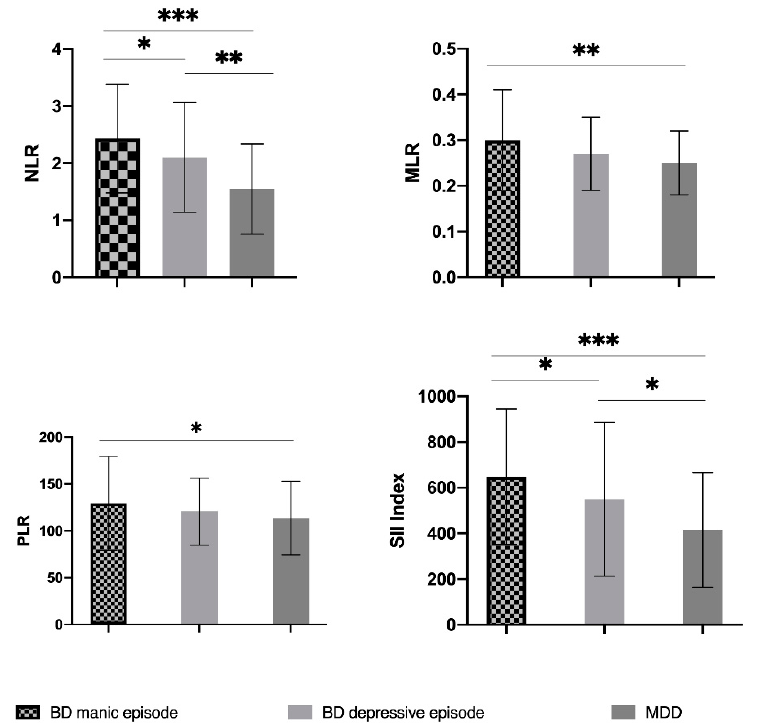
Figure 1. Neutrophil-to-lymphocyte ratio, platelet-to-lymphocyte ratio, monocyte-to-lymphocyte ratio, and systemic immune-inflammatory index levels in bipolar disorder patients with manic episode, bipolar disorder patients with depressive episode and patients with major depressive disorder and the comparison of ratios between groups (representation of mean ± standard deviation). The statistical significance was evaluated with Mann-Whitney U test. *, p < 0.05; **, p < 0.01; ***, p < 0.001; NLR, neutrophil-to-lymphocyte ratio; PLR, platelet-to-lymphocyte; MLR, platelet-to-lymphocyte; SII, systemic immune-inflammatory; BD, bipolar disorder; and MDD, major depressive disorder.